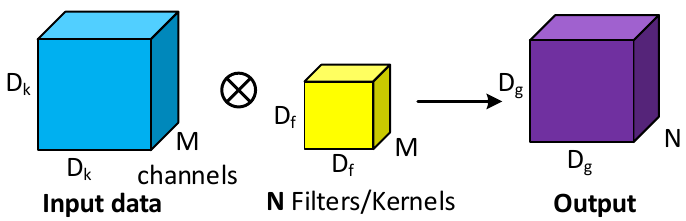
Figure 1. The operation of a conventional